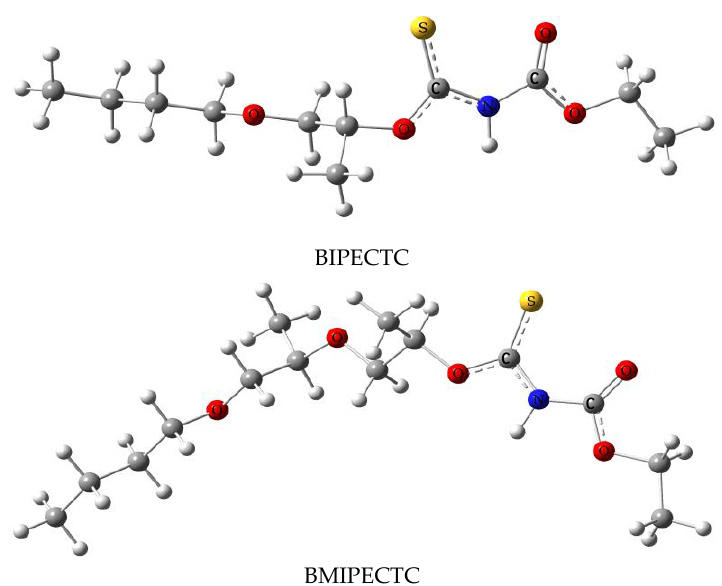
Figure 12. Optimized geometries of IPETC, IBECTC, BIPECTC and BMIPECTC.